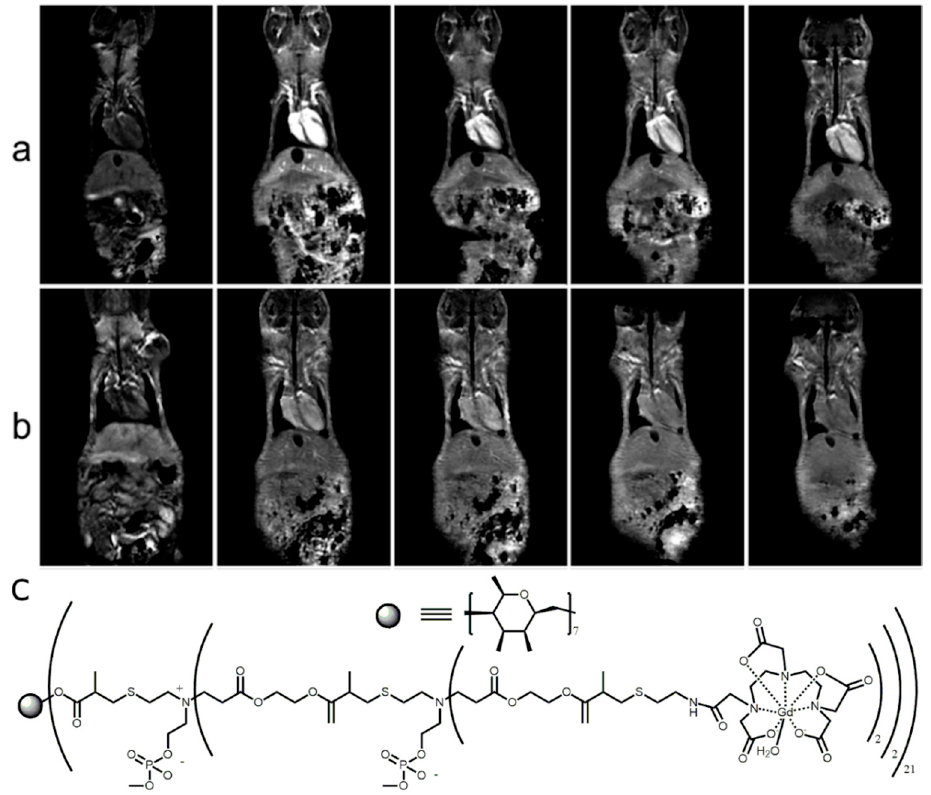
Figure 5. Representative T1 weighted multislice image of the mice heart after 0.1 mM Gd/kg injection of G2/MOP–DTPA–Gd contrast ( a ) and Magnevist ( b ). The superior contrast-to-noise ratio was observed from the heart after the G2/MOP–DTPA–Gd injection. The images ( a ) and ( b ) are reprinted with permission from publisher [24]. ( c ) The molecular structure of the developed G2/MOP-DTPA-Gd CD-based contrast agent.